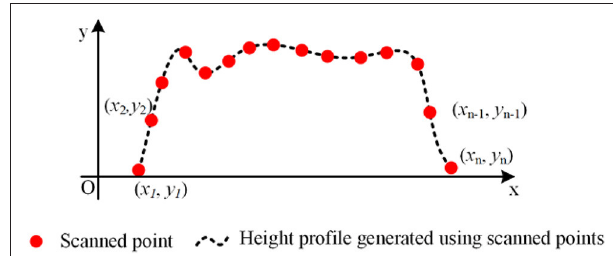
FIGURE 4 | Estimated area (the area under height profile curve) using Trapezoidal